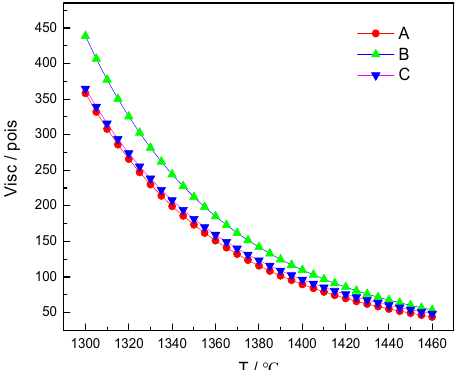
Figure 3. The calculated viscosities of imitation basalt compounds plotted as a function of temperature: ( A ) fly ash 1 imitation basalt compound; ( B ) fly ash 2 imitation basalt compound; ( C ) coal gangue imitation basalt compound.